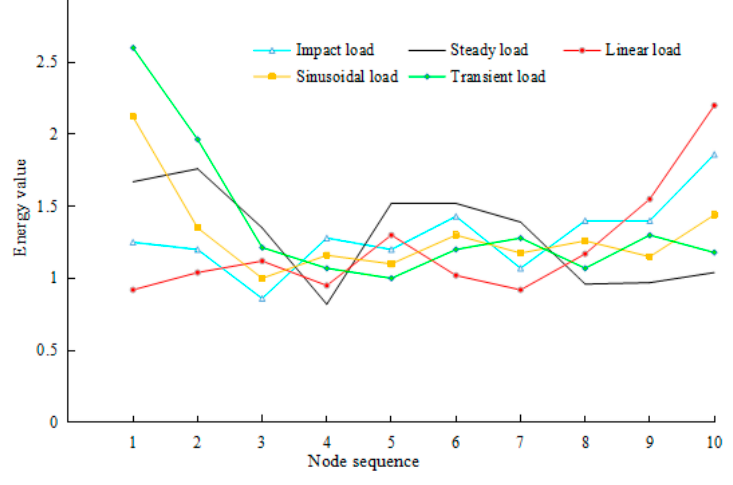
Figure 6. Energy distribution of nodes.